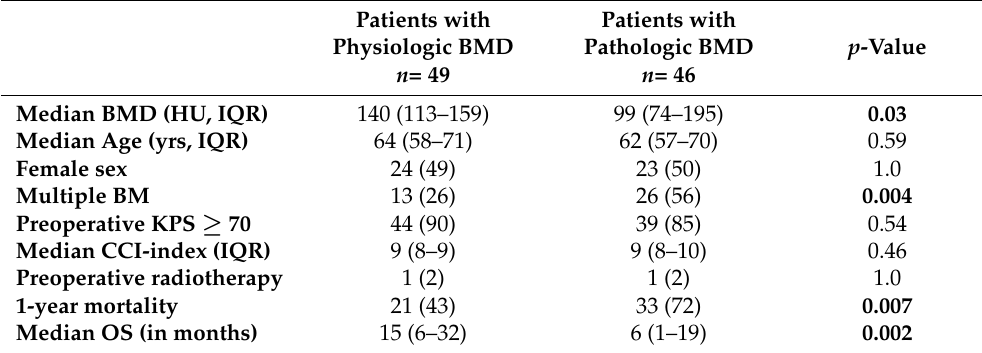
Table 2. Patient- and disease-related characteristics dependent on the presence of physiologic and pathologic BMD-levels *.